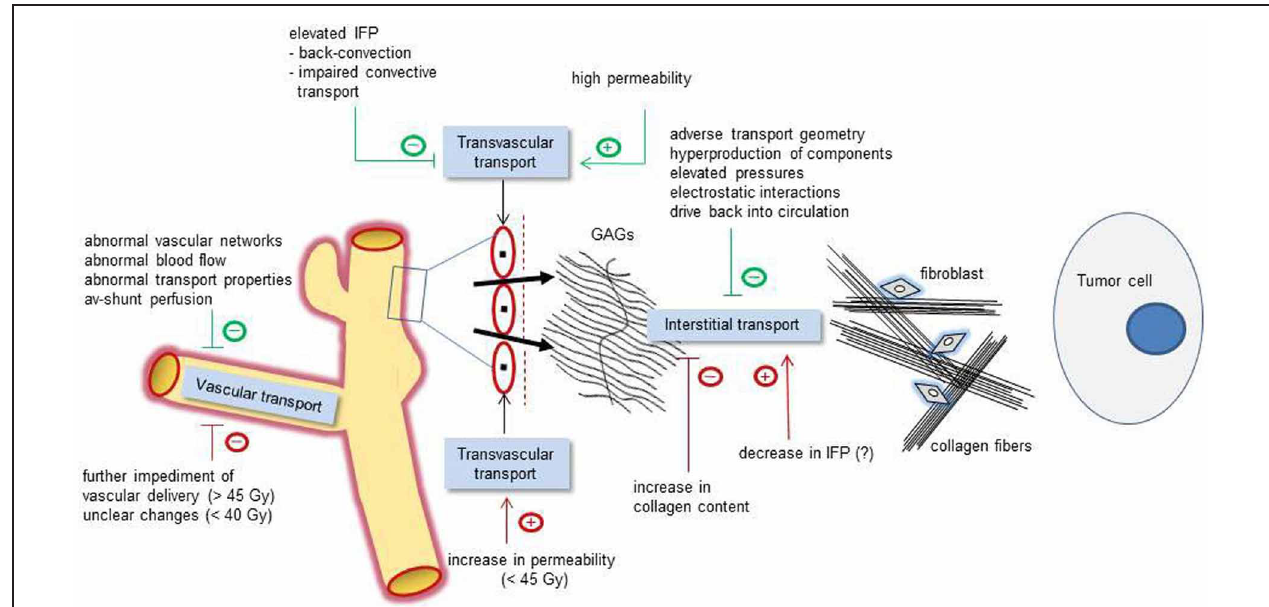
of macromolecules is hindered by an adverse transport geometry (including enlarged interstitial volumes and transport distances), by a hyperproduction of interstitial components (e.g., stromal cells, collagen fibers, interstitial matrix), by elevated pressures (IFP, OP, and accumulated solid stress), electrostatic interactions, and drive back into the circulation. IFP, interstitial fluid pressure; OP, oncotic pressure; GAGs, negatively charged